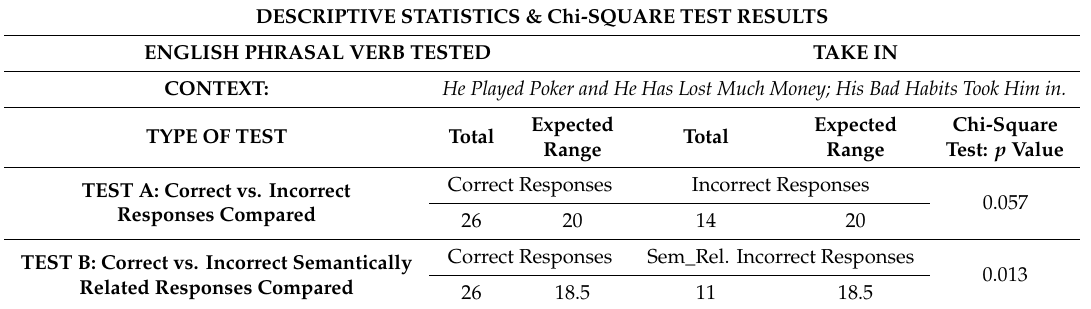
Table 4. Chi-square tests for take in